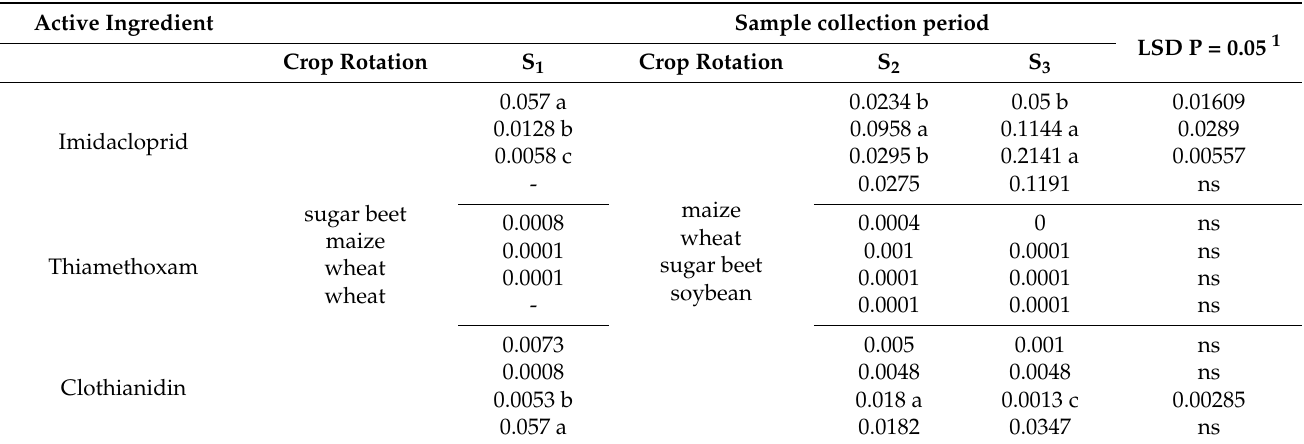
Table 4. Determined residues of neonicotinoids (in mg/kg) in earthworm samples from fields with different crop rotations in